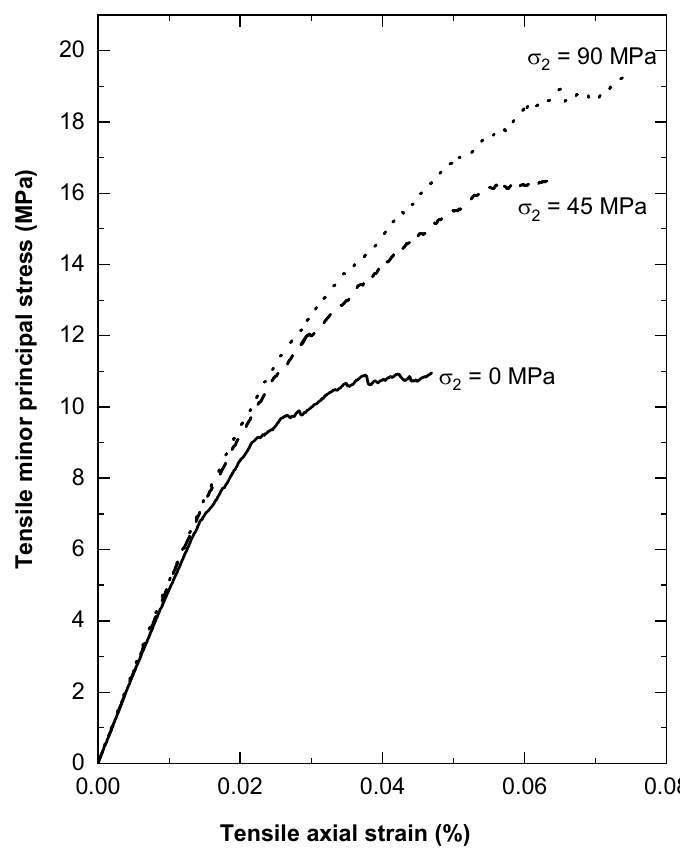
Figure 16. Confined extension test at σ 2 = σ 1 = 90 MPa, σ 2 = σ 1 /2 = 45 MPa, and σ 2 = 0 (stress–strain curve showing the impact of σ 2 in the numerical sample).